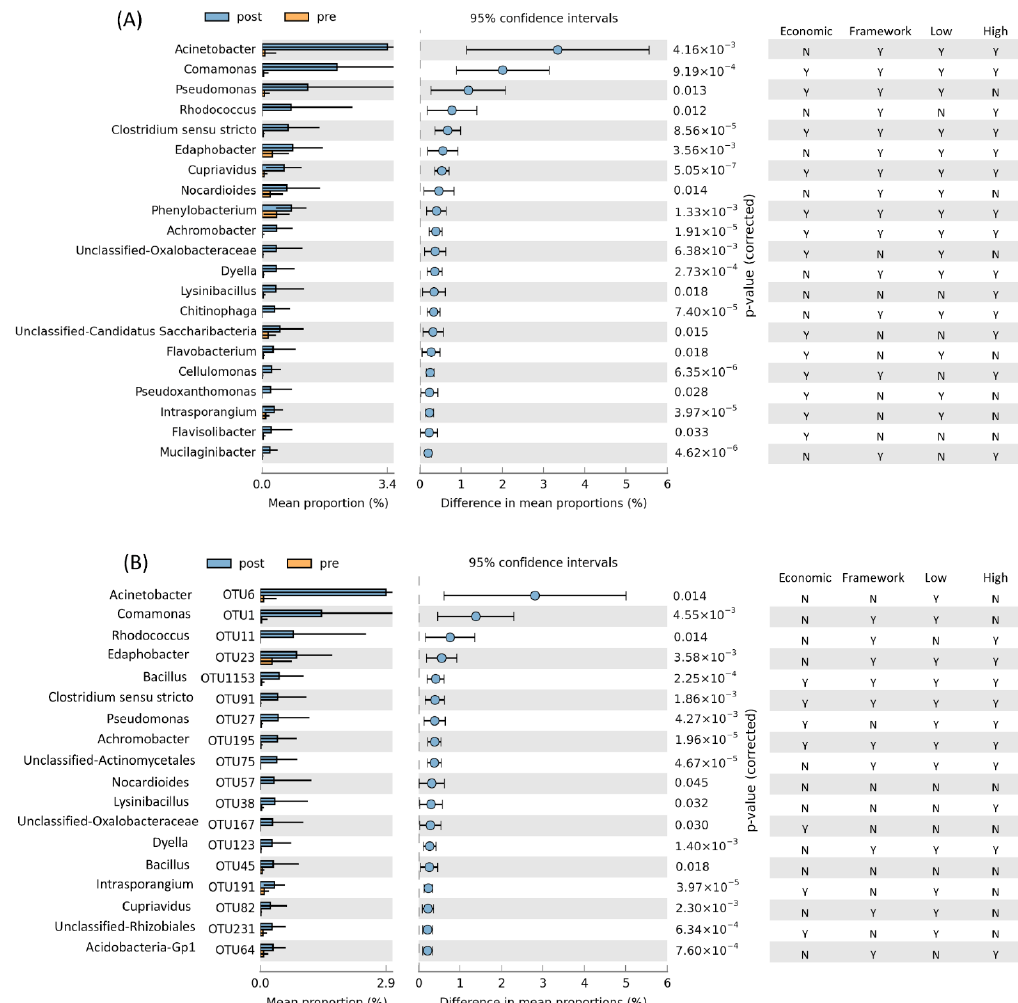
Figure 3. Taxa with significant increase in relative abundance in soils (based on all treatments combined) when incubated with isoprene (post) compared with before incubation (pre): ( A ) Genus level, ( B ) OTU level. The right-hand column shows whether the indicated genus or OTU was significantly more abundant (Y) or not (N) in soils from beneath Economic crops and Framework trees, and with lower isoprene concentration and higher isoprene concentration, each relative to their respective soils before incubation. Analysis was performed using STAMP software. See Methods for details.